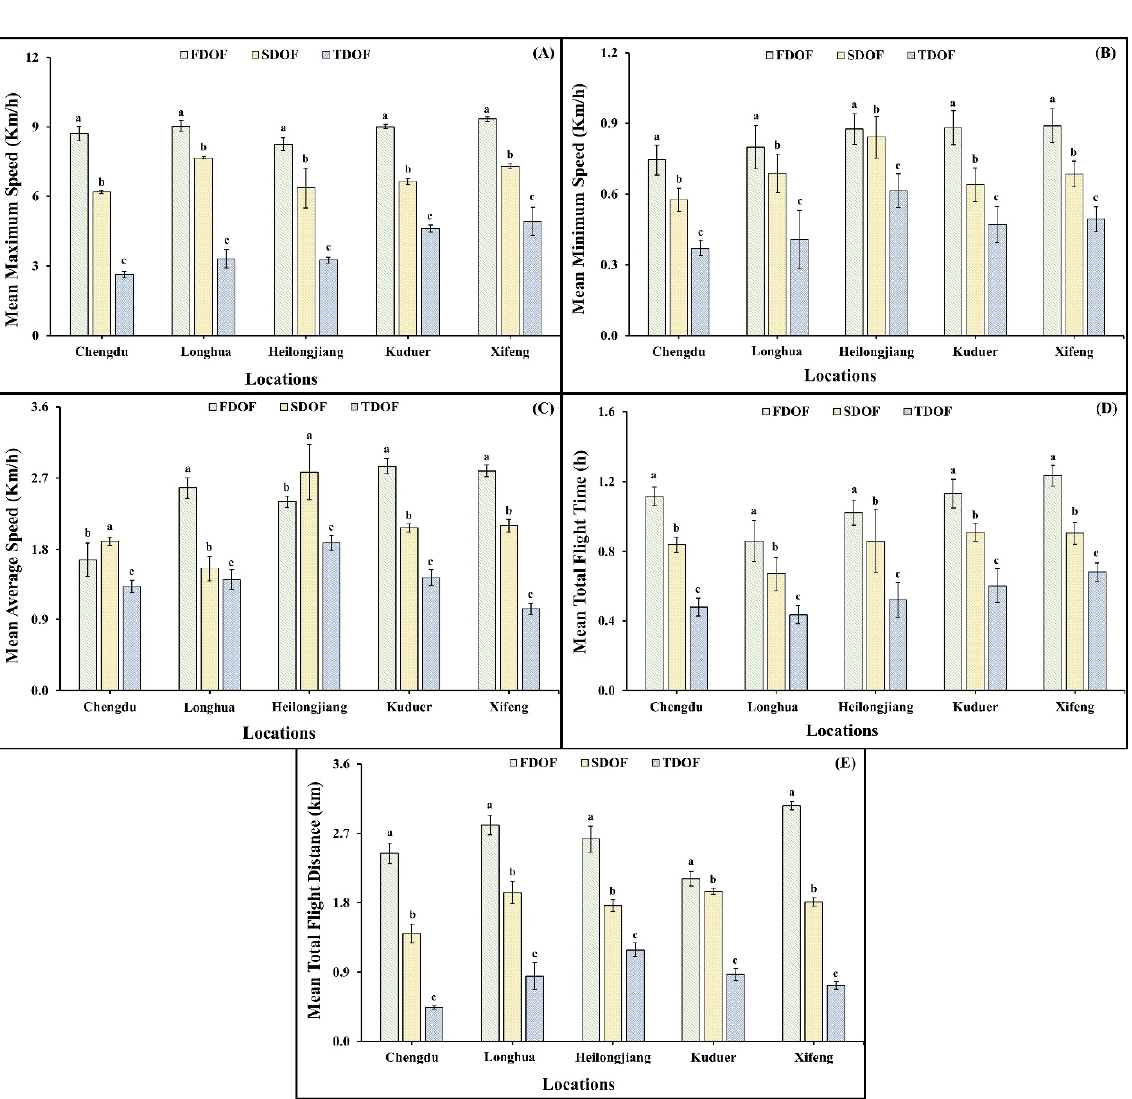
Figure 6. Effect of age on different parameters regarding the flight capability of female Asian spongy moths ( L. dispar asiatica ) from five different geographical locations in China: ( A ) Effect of age on the mean maximum speed of females from five different sites; ( B ) Effect of age on the mean minimum speed of females from five different sites; ( C ) Effect of age on the mean average speed of females from five different sites; ( D ) Effect of age on the mean total flight time of females from five different sites; ( E ) Effect of age on the mean total flight distance of females from five different sites. Letters (a,b,c) indicate the variation in flying capability with respect to female age for each locality. A level of significance of p < 0.05 was used. Plots are with SE.